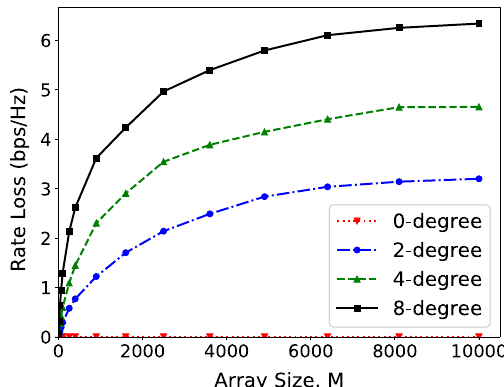
Fig. 8 Rate loss changing with base-station array size. The plot is based on simulated channels with different angle